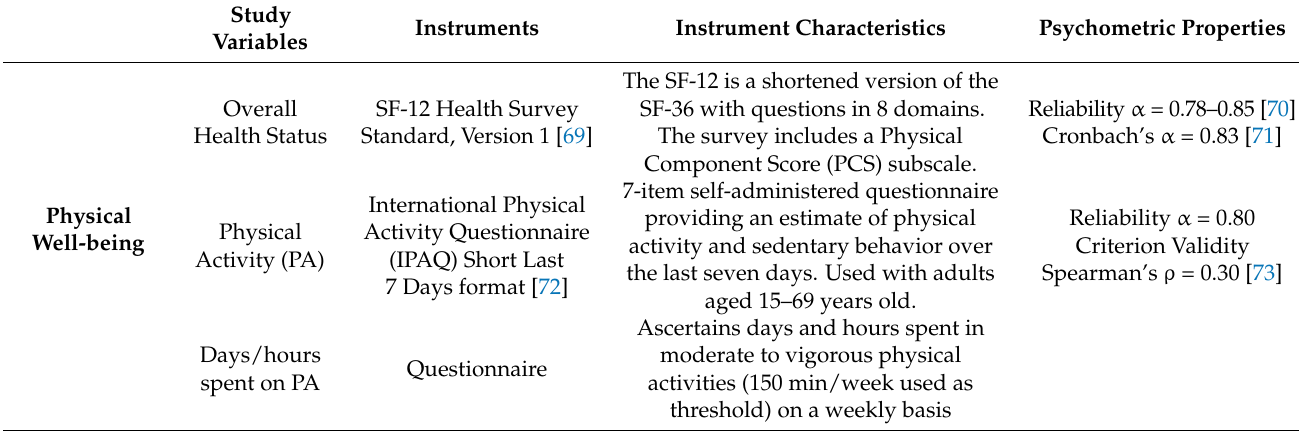
Table 1. Measures Used in the Current